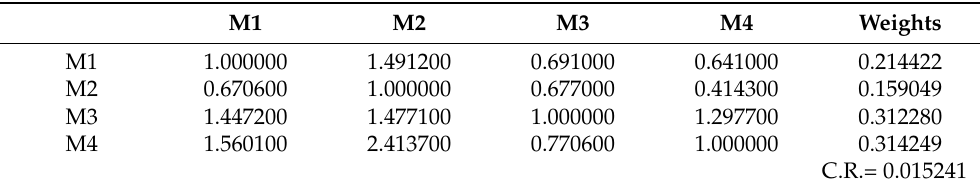
Table 9. Pair-wise comparative matrix with defuzzification and local weight of parameters at level 1.